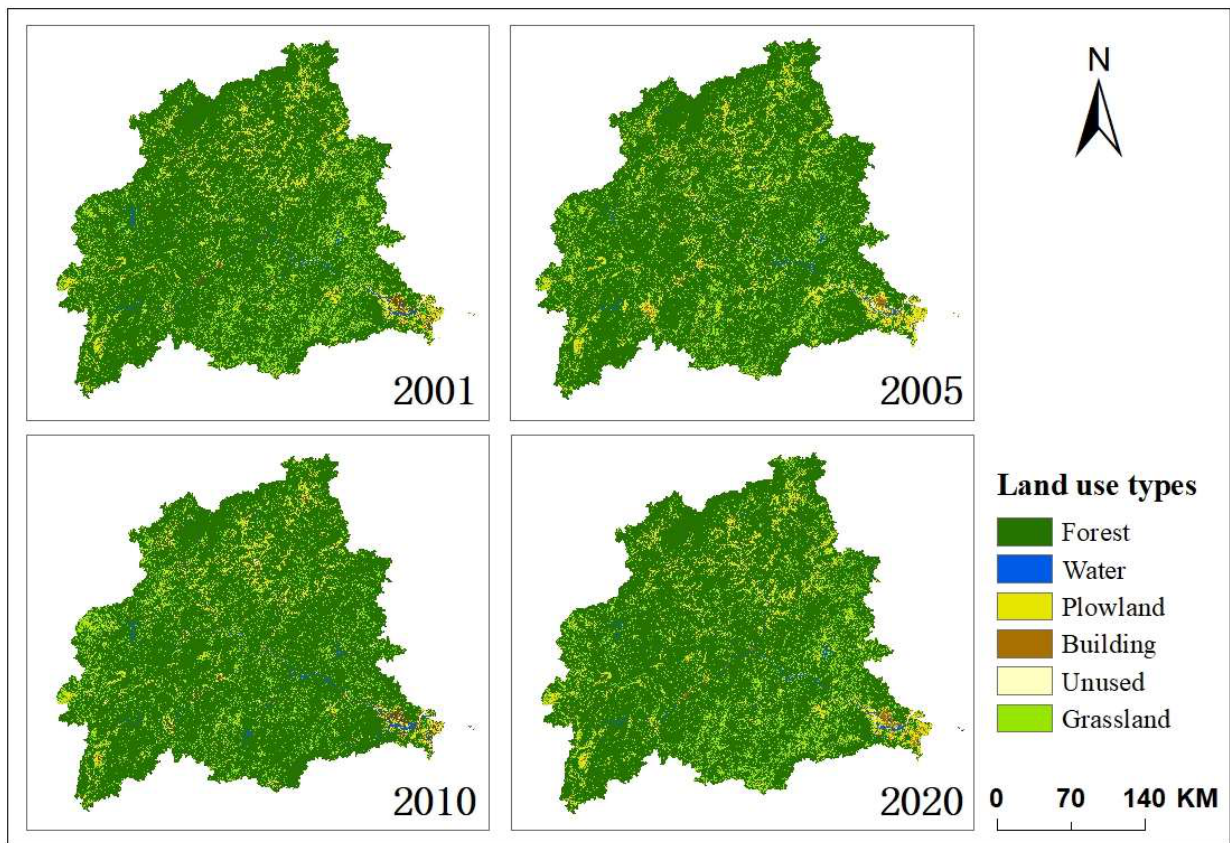
Figure 4. Basin land cover classification.